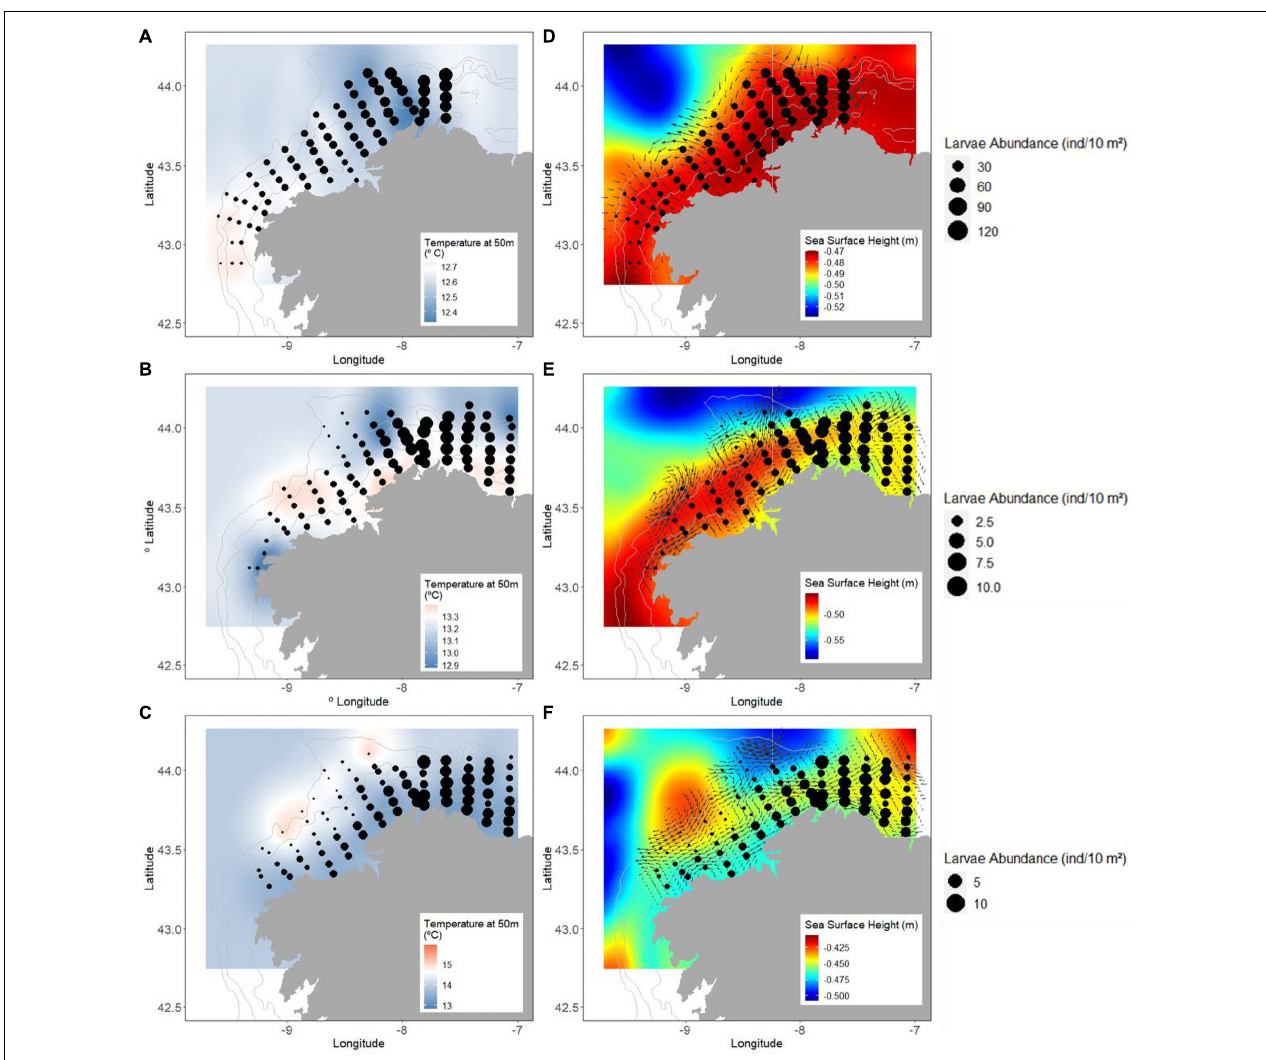
FIGURE 5 | Predicted larval abundance (black dots) and temperature in (A) March 2012, (B) March 2017, and (C) June 2017. Predicted larval abundance (black dots), sea surface height (SSH), and currents in (D) March 2012, (E) March 2017, and (F) June 2017. Note the difference in the scale of the color bar and in the dot